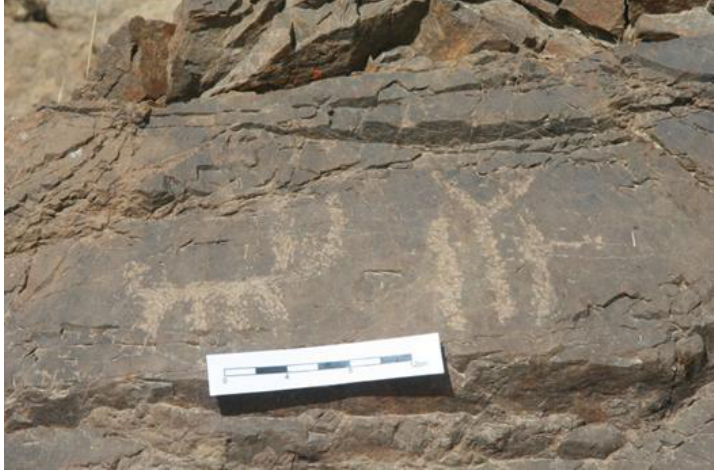
Figure 7. Barzgale, Ibex motif with geometric marking [17].